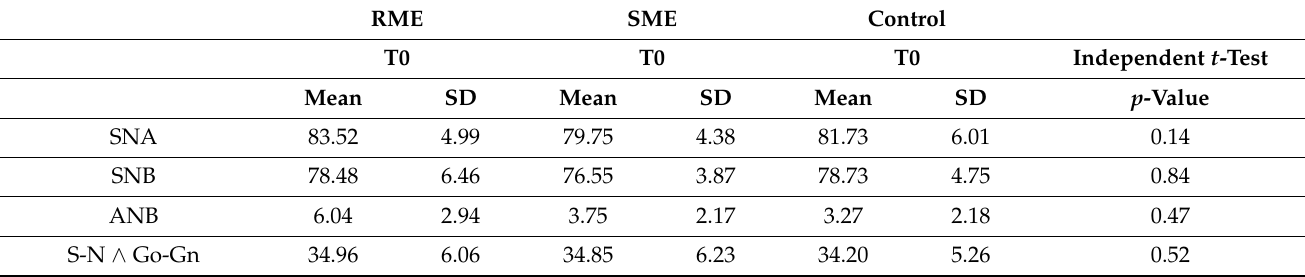
Table 2. Cephalometric measurements of the three groups reported at T0 and independent t -test analyses at